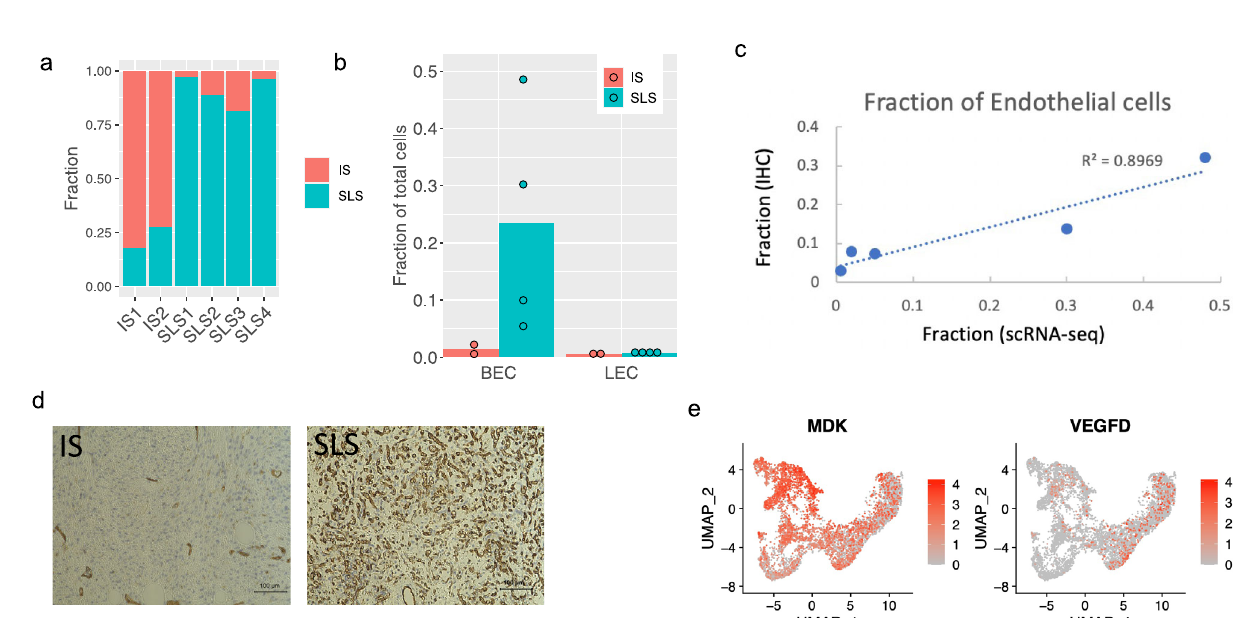
Fig. 3 | The stem-like population of AML cells may contribute to rapamycin resistance. a UMAP plot of primary cultures derived from AML tumor colored by treatment. Cells were treated with DMSO as control (red) or 20nM rapamycin (cyan)for24hoursbeforescRNA-Seq. b UMAPplotoftheAML-derivedprimarycell culture, colored by clusters. c Expression of 5 AML markers in the primary AML culture before and after rapamycin treatment (as in A). d CTSK expression in cells beforeandafterrapamycin(asinA). e Cluster4intheDMSOcontrolgroupshowed high stemness score, calculated using a panel of 50 cancer stem cell marker genes